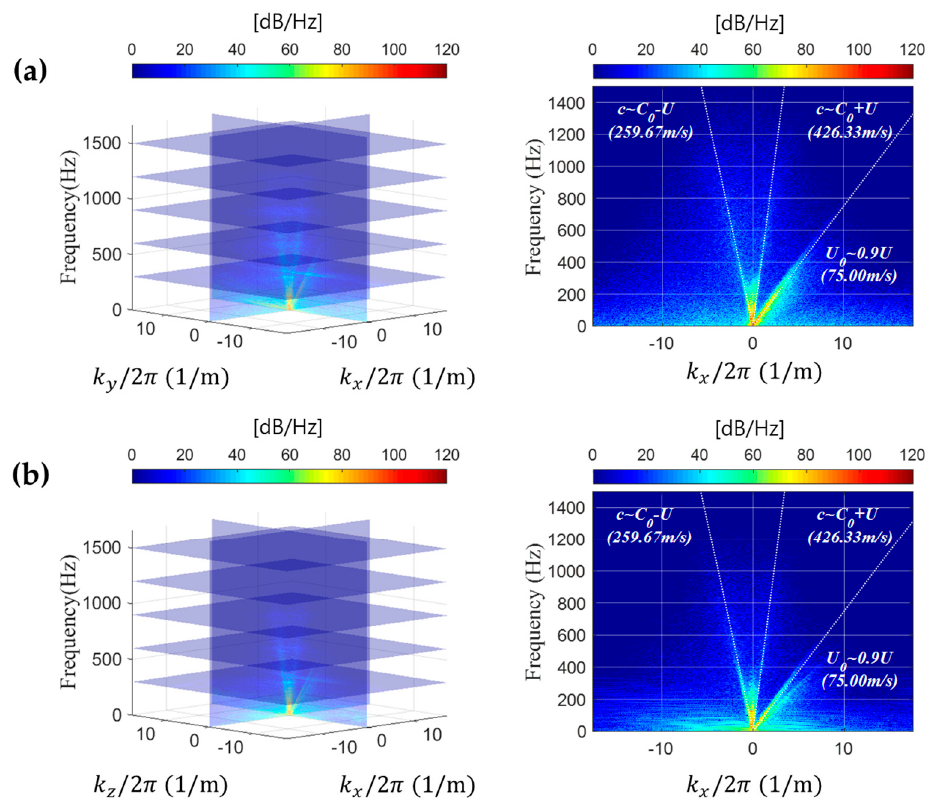
Figure 16. Three-dimensional power spectral density diagram (left) and diagrams at a given k y = 0 and k z = 0 (right)—reference pressure 20 µ Pa; ( a ) roof wall region and ( b ) left-side wall region.